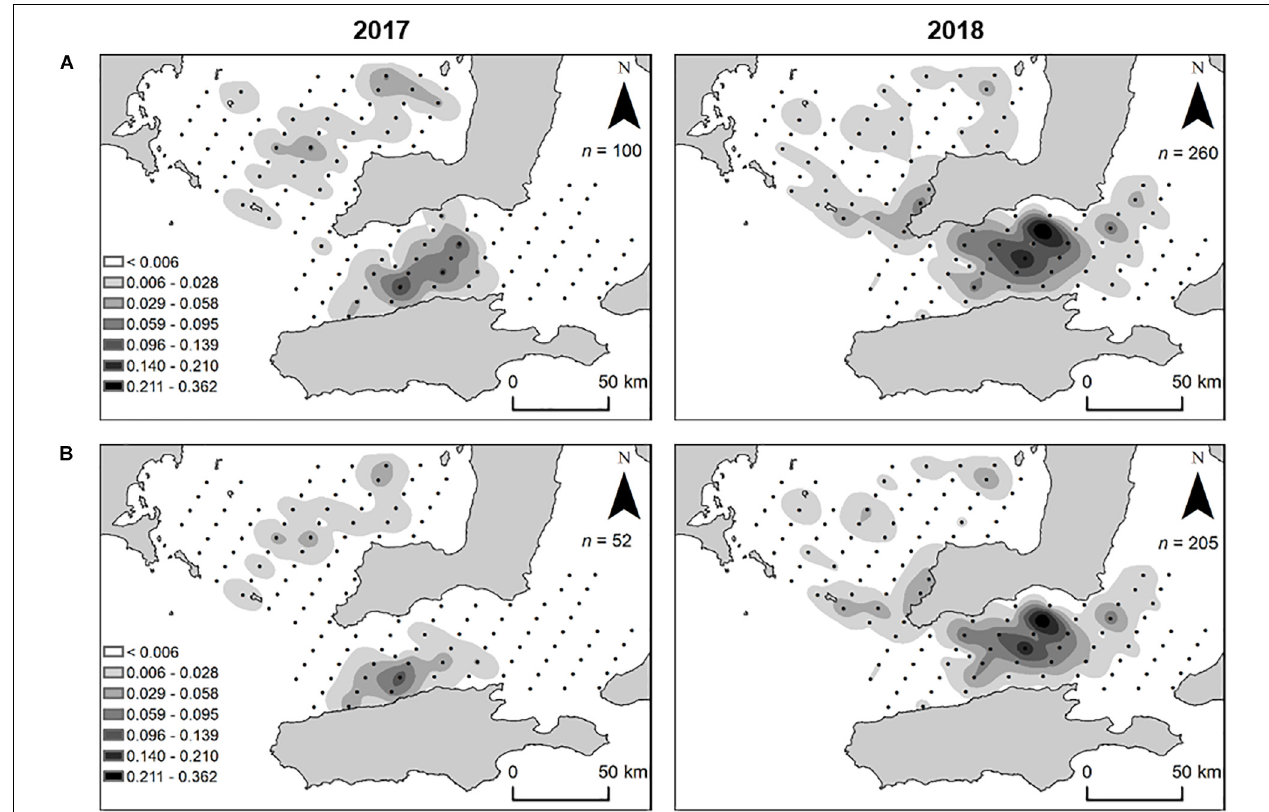
FIGURE 6 | Spatial distribution and density (larvae m - 3 ) of King George whiting larvae collected from Southern Spencer Gulf and Investigator Strait, South Australia, in 2017 and 2018. (A) All larvae captured; (B) larvae ≤ 5 mm SL. For clarity, maps show larval density from oblique tows which accounted for 89.7% of larvae captured ( n =